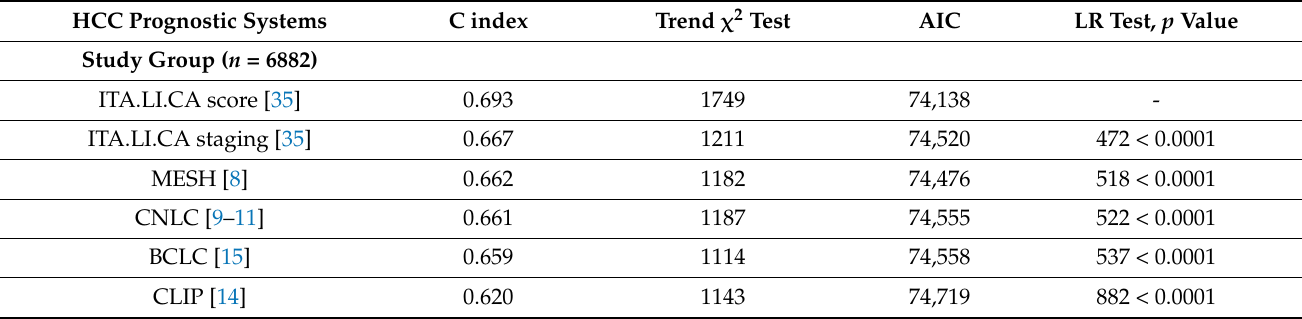
Table 7. Discrimination ability, monotonicity of gradient, and homogeneity of different HCC prognostic systems. HCC Prognostic